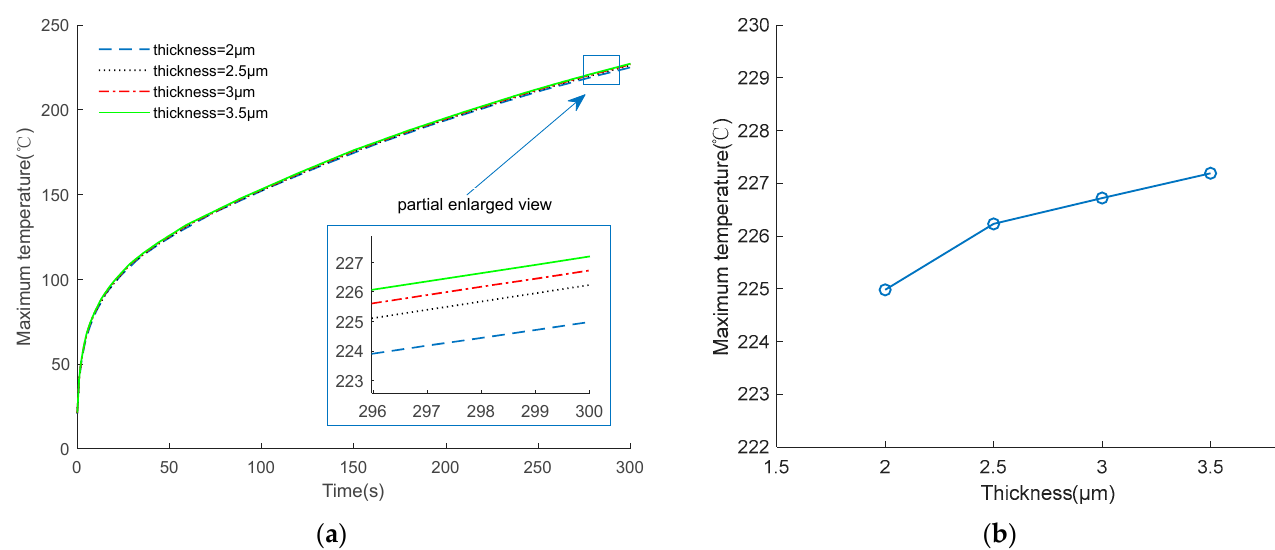
Figure 12. Temperature changing of EC element under different thicknesses. ( a ) Temperature change curve; ( b ) Maximum temperature at 300 s.